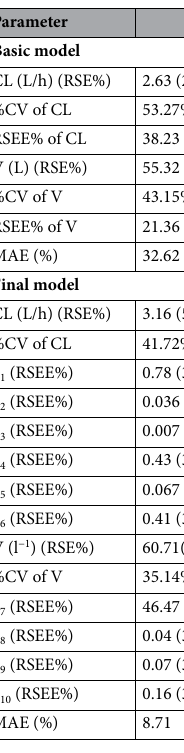
Table 6. Summary of results for the basic and final population models. %CV as coefficient of variation; RSEE% as relative standard prediction error; θ as regression parameter; RSE% as relative standard error.